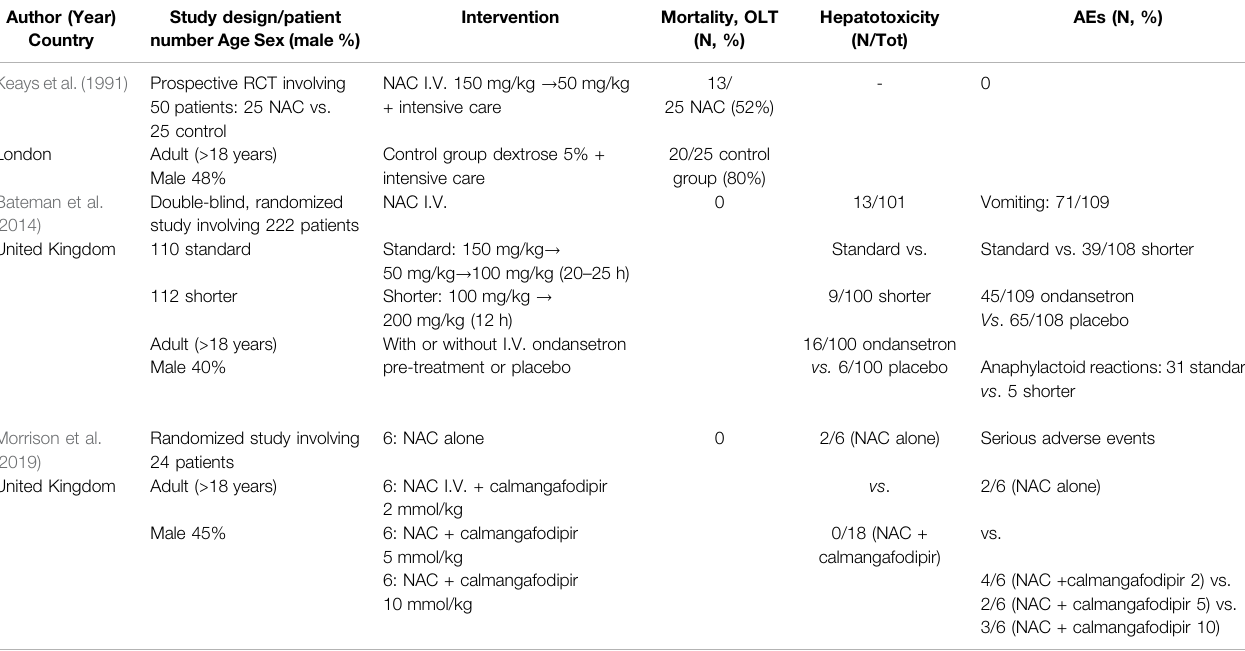
TABLE 3 | Study design characteristics and outcomes of three clinical trials included in the analysis. Author (Year) Study design/patient Country number Age Sex (male